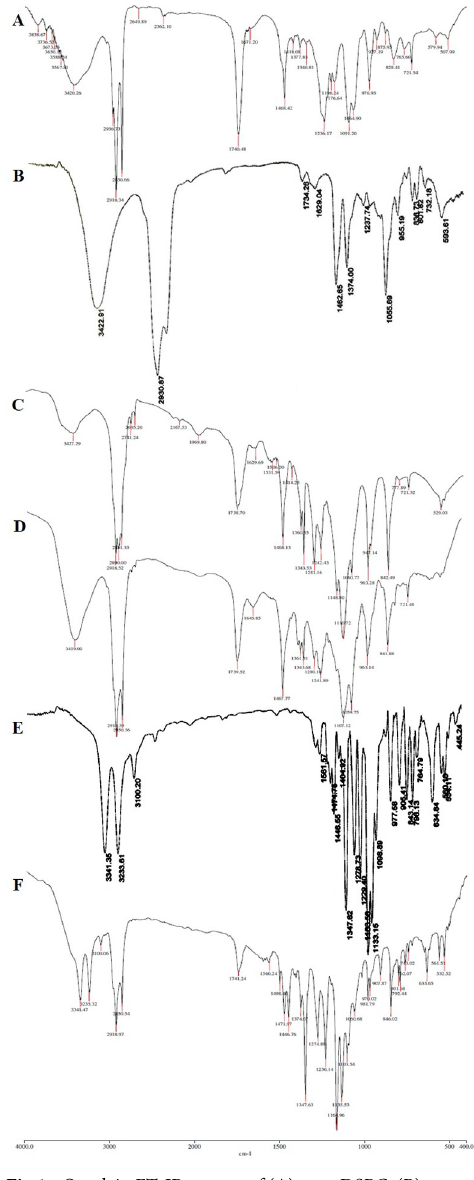
Fig 1. Overlain FT-IR spectra of (A) pure DSPC, (B) pure cholesterol, (C) pure PE-PEG, (D) physical mixture of excipients for the formulation, (E) pure CLB, and (F) physical mixture of CLB and excipients for the formulation